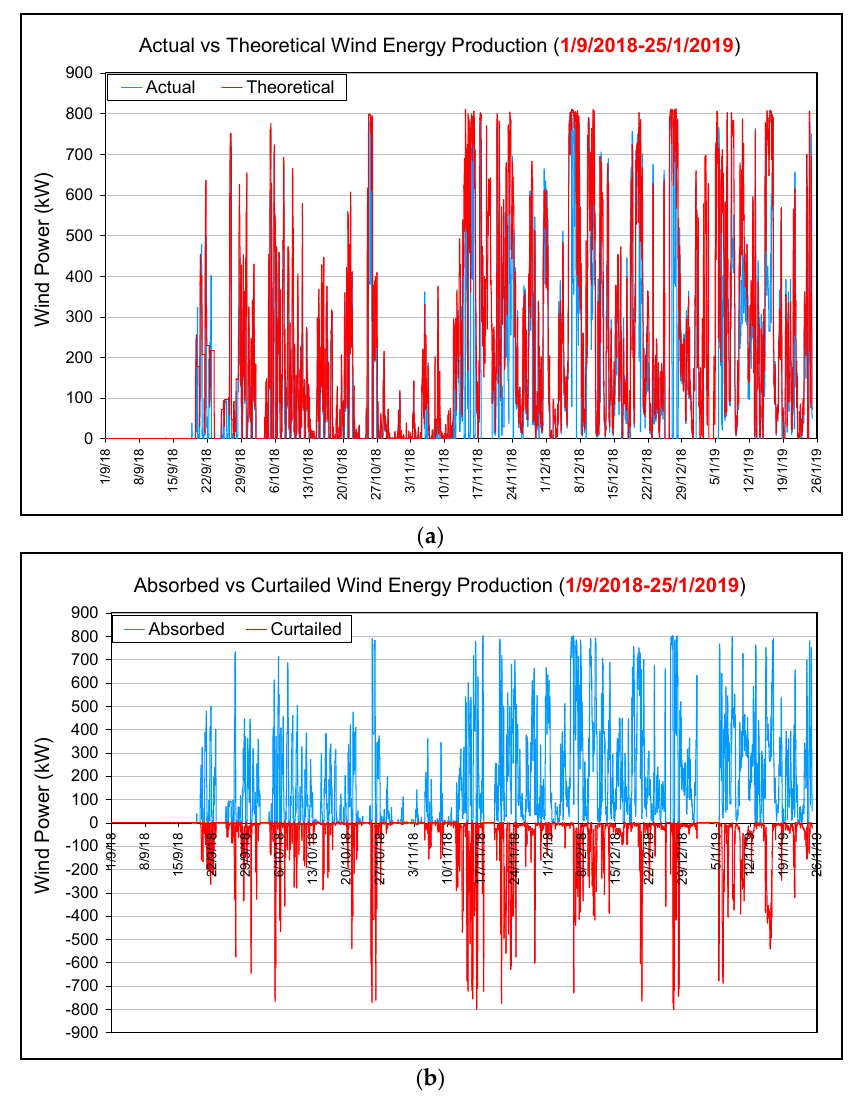
Figure 19. ( a ) Actual vs theoretical; ( b ) absorbed vs curtailed wind energy over the period of TILOS demonstration.